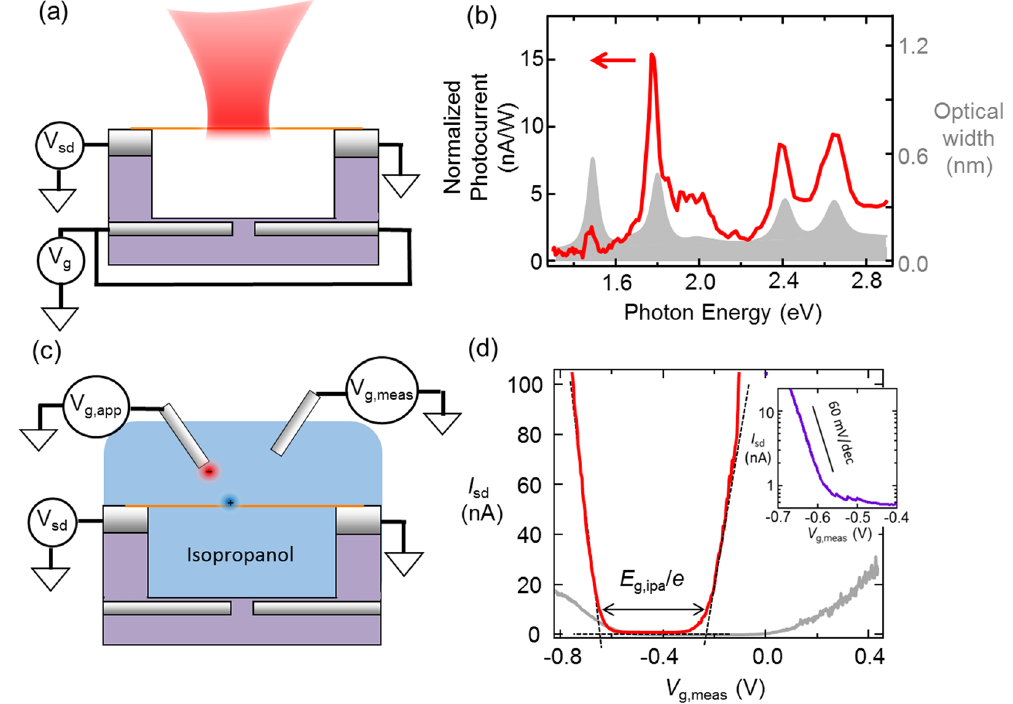
Figure 6. Method of measuring the change in transport gap for wide-gap CNTs. ( a ) Schematic of the photocurrent spectroscopy measurement that is used to determine chiral index. ( b ) The spectral dependence of the photocurrent (red line) plotted together with the expected absorption cross section of a (20,18) CNT. ( c ) Schematic of a liquid-gating measurement. ( d ) I sd − V g in pure IPA (gray line) and salty IPA, 30 mM of TBAF, (red line). Inset: Log plot of the sub-threshold region using salted IPA.